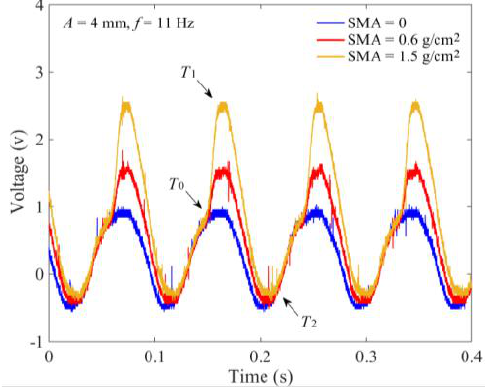
Figure 7. Output voltage of the cantilever force sensor at different SMAs.